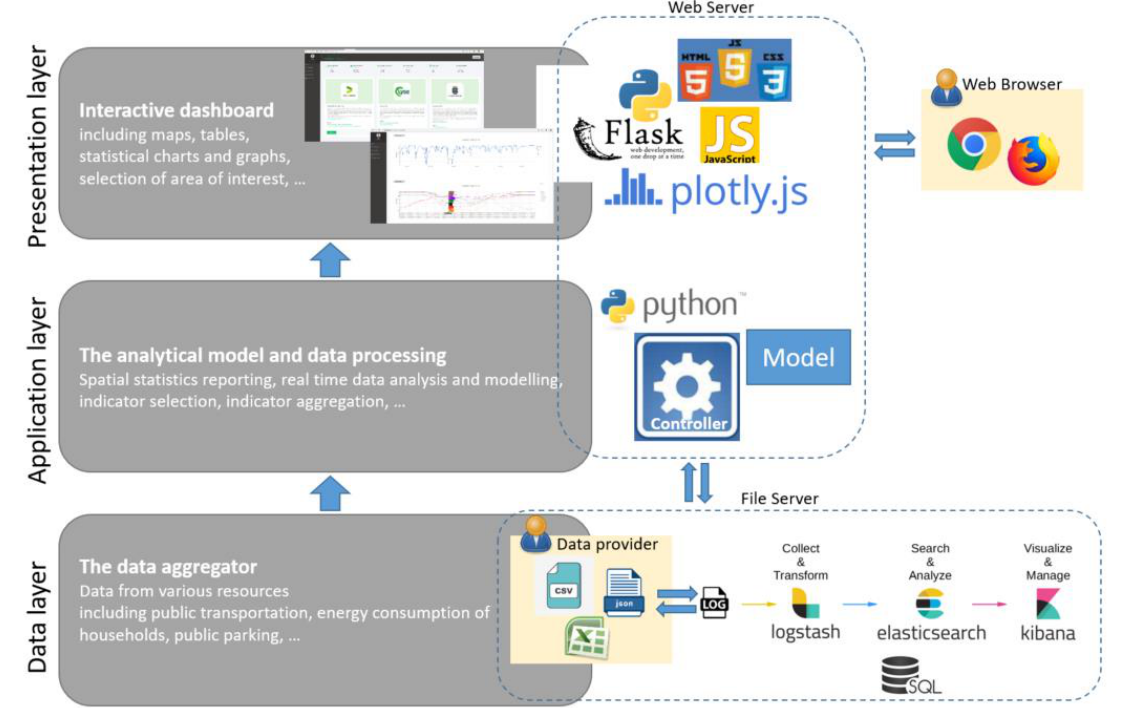
Figure 2. Conceptual three-tier architecture of the Triangulum City Dashboard.